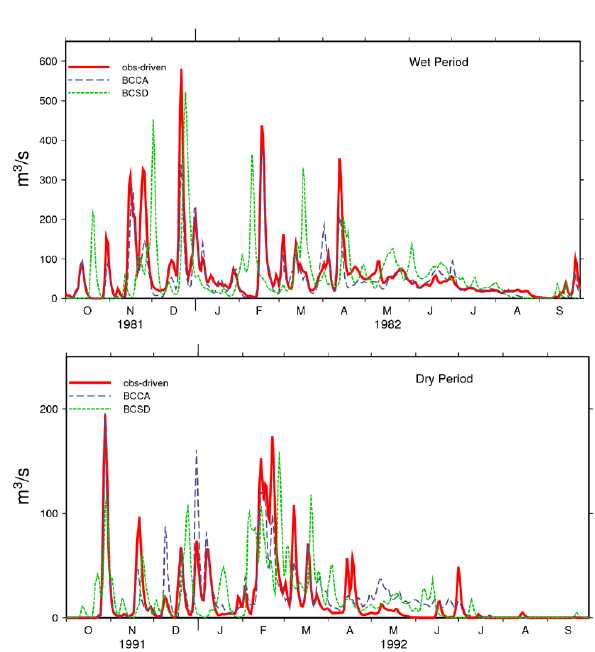
Figure 8. Simulated streamflow for the NF_AM site (listed in Table 1) using driving 2 Fig. 8. Simulated streamflow for the NF AM site (listed in Ta- meteorology from BCCA and BCSD downscaling methods, and from the hydrologic model 3 ble 1) using driving meteorology from BCCA and BCSD down- scaling methods, and from the hydrologic model simulation driven simulation driven by gridded observations. A wet water year (top panel) and dry water year 4 by gridded observations. A wet water year (top panel) and dry water (bottom panel) are shown. 5 year (bottom panel) are